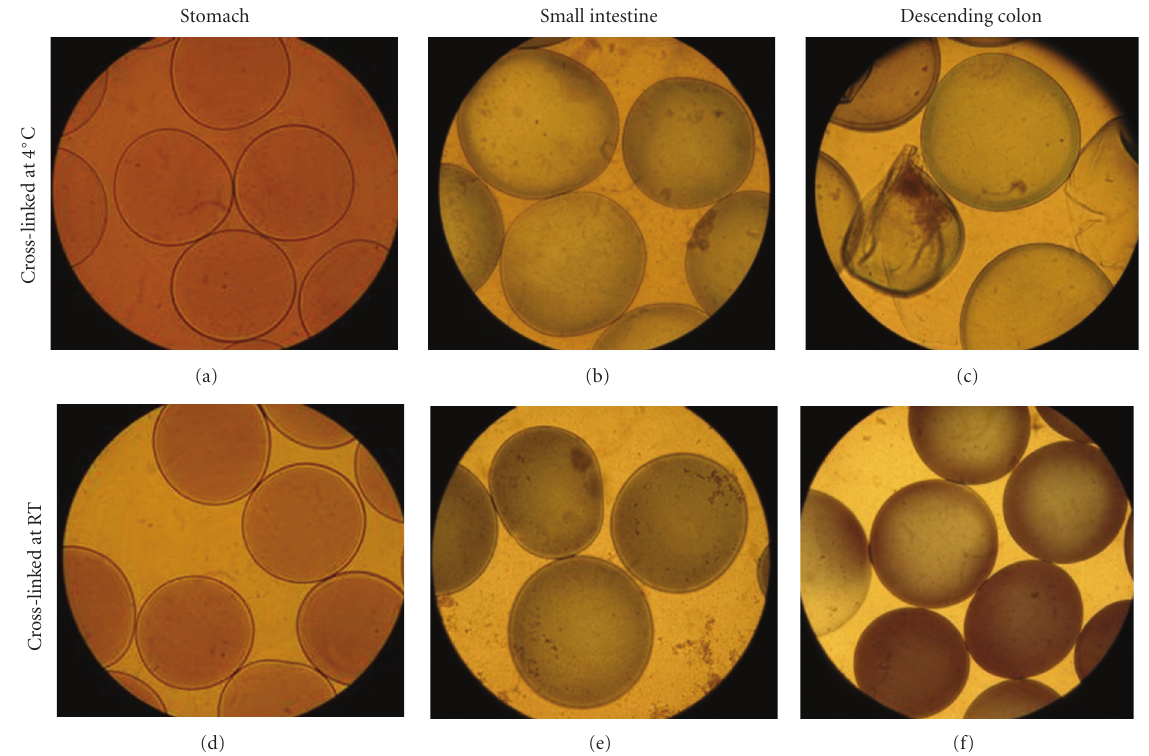
Figure 2: Microphotographs of the GCAC microcapsules cross-linked at 4 ◦ C (a)–(c) and RT (d)–(f) during the simulated human GI transit in the simulated stomach, small intestine, and descending colons. Original magnification at